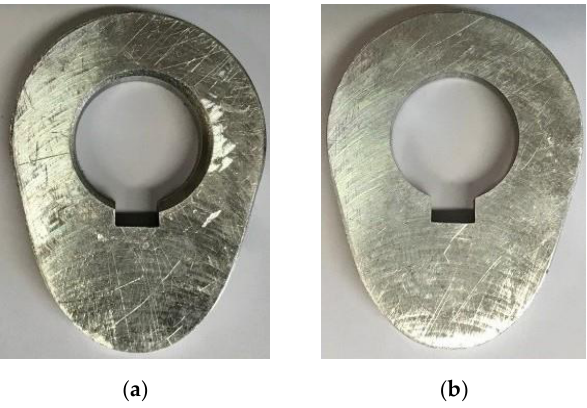
Figure 4. Cams after the wear tests (200 × 10 3 rev): ( a ) AA5083-N0-T200; ( b ) AA5083-N2-T200.